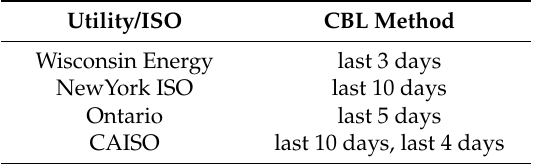
Table 2. Details of the last Y days methods used by certain utility companies and